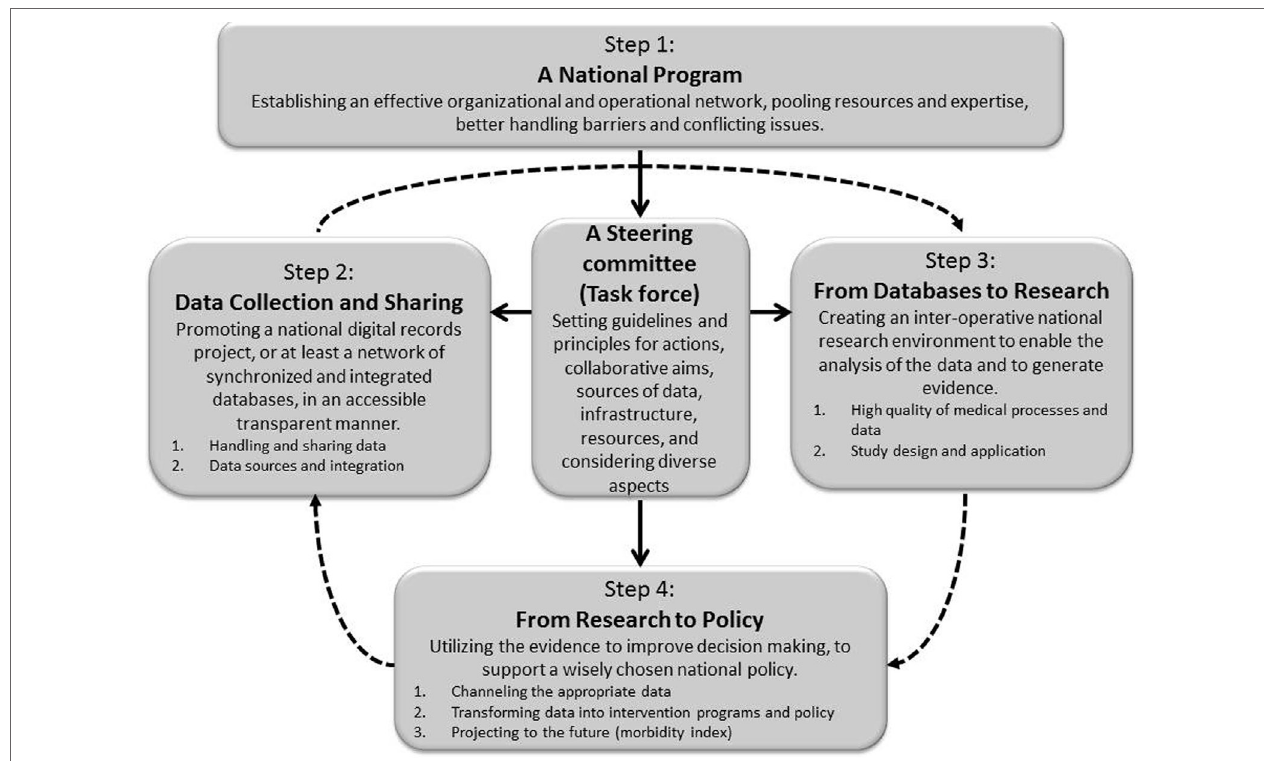
FigUre 1 | Schematic representation of a four-step model, aimed at bridging the gaps between data collection and sharing, research, data analysis, and policy making. Solid lines indicate direct relationship (such as initiating, directing, connecting, synchronizing, coordinating, monitoring, managing, etc.) between process components or steps of the model, while dashed lines indicate a non-direct relationship (such that utilizing “outcomes” of the former prerequisite step).